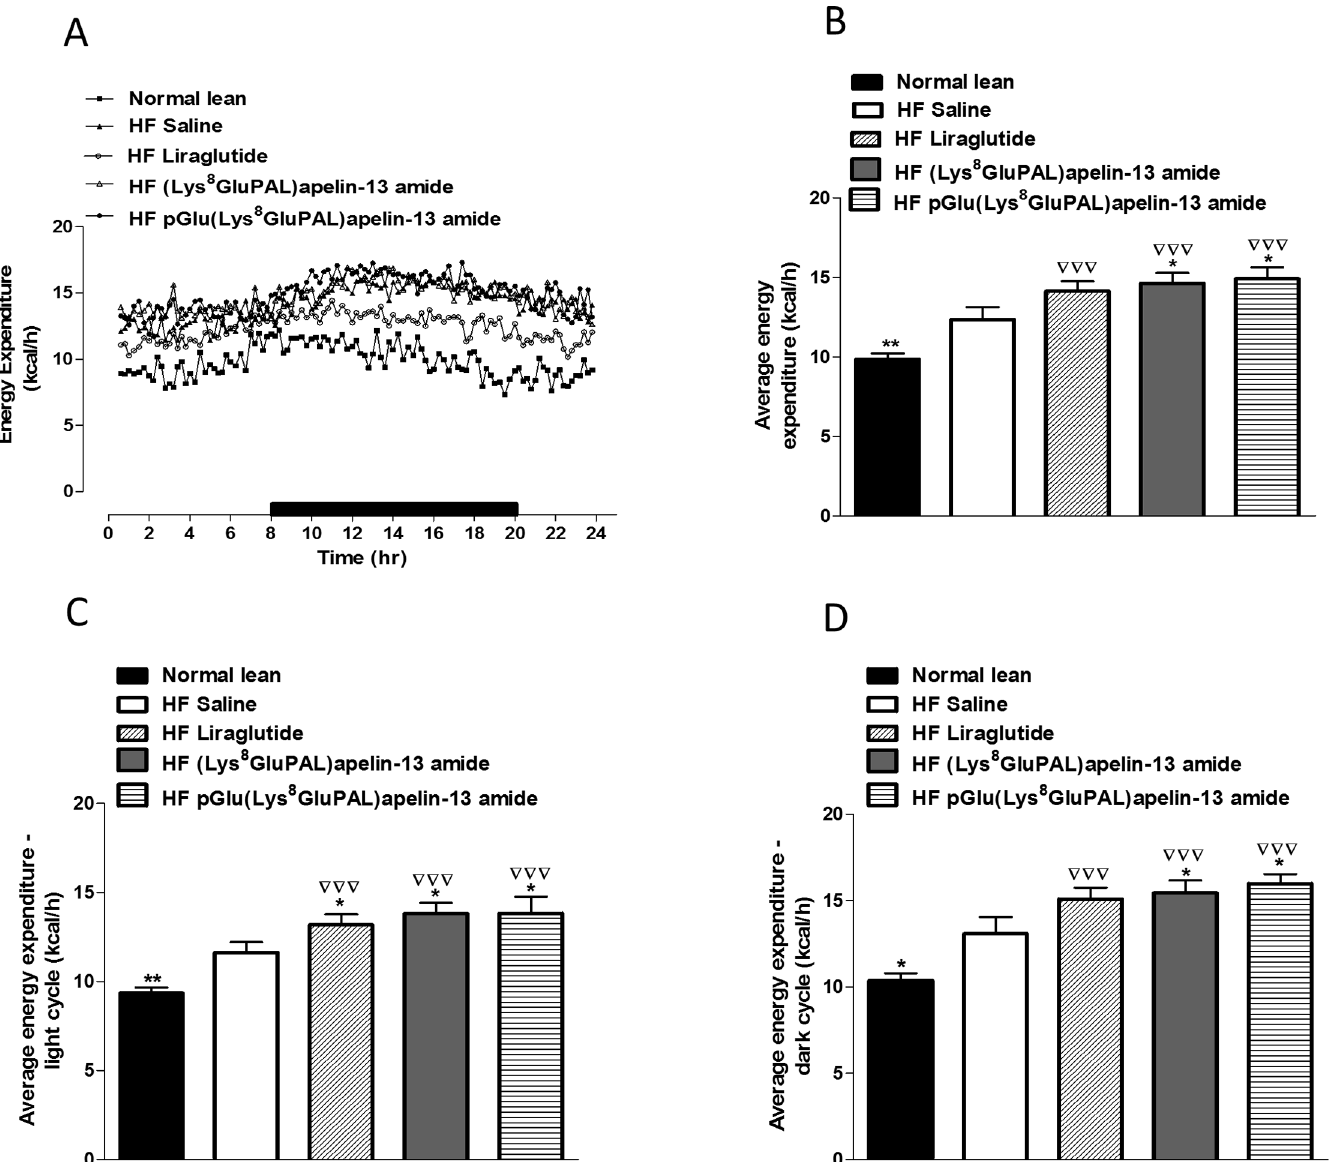
Fig 8. Effect of once daily i.p. administration of liraglutide, (Lys 8 GluPAL)apelin-13 amide or pGlu(Lys 8 GluPAL)apelin-13 amide (each at 25 nmol/kg bw) on energy expenditure (A). Following 35 days treatment, mice were placed in CLAMS metabolic chambers for 24 h (12 h dark period as shown by the black bar) and energy expenditure calculated using RER with the following equation: (3.815 + 1.232 x RER) x VO 2 . Average energy expenditure (B), energy expenditure in the light (C) and dark cycles (D) are also included. Values represent the mean ± S.E.M. (n = 6) where (cid:3) p < 0.05 and (cid:3)(cid:3) p < 0.01 is compared to high-fat fed saline treated mice and 555 p < 0.01 is compared to normal